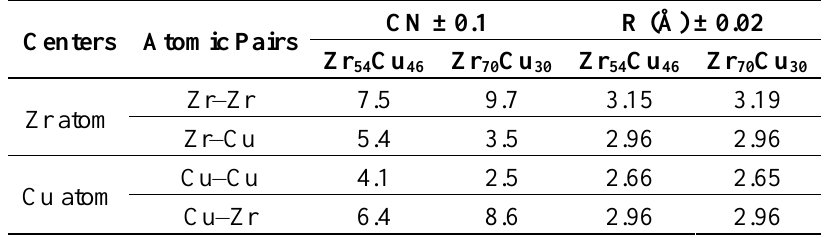
Table 1. Atomic structural information obtained from the RMC simulation, including: coordination numbers (CNs) around Zr or Cu centers and atomic-pair distances